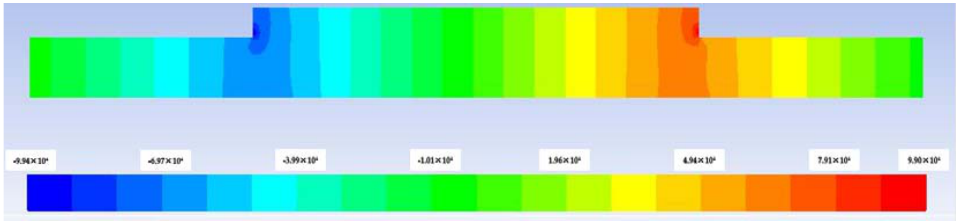
Figure 5. Pressure cloud map of rectangular texture flow field with texture depth of 5 μ m.